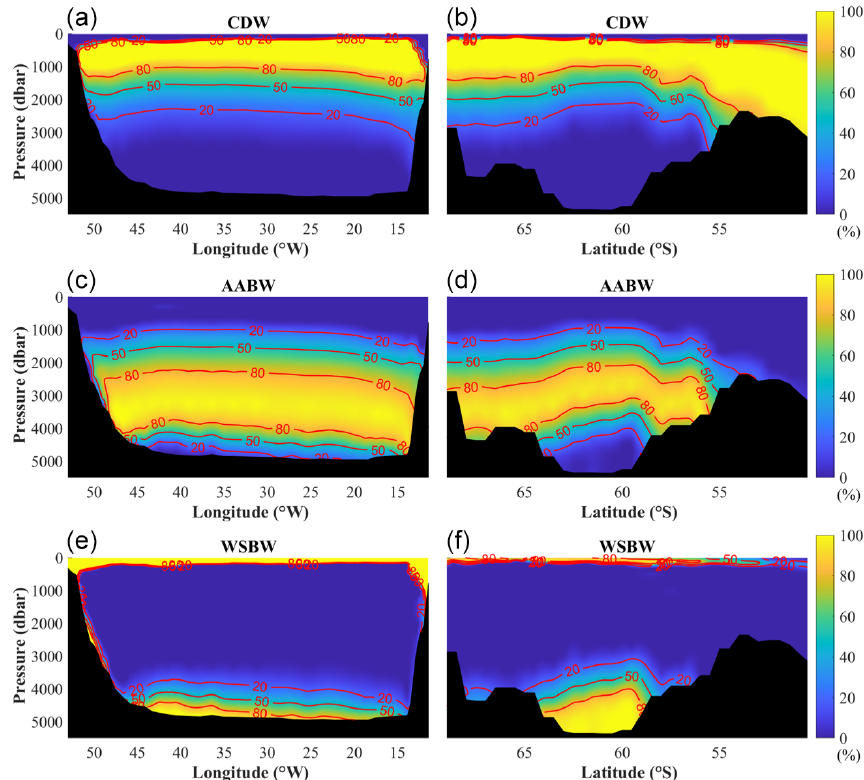
Figure 17. Distribution of southern water masses (CDW, AABW and WSBW) based on SR04 sections. Panels (a) , (c) and (e) show the west (zonal) part, and (b) , (d) and (f) show the east (meridional) part of the section. The contour lines show fractions of 20%, 50% and 80%.